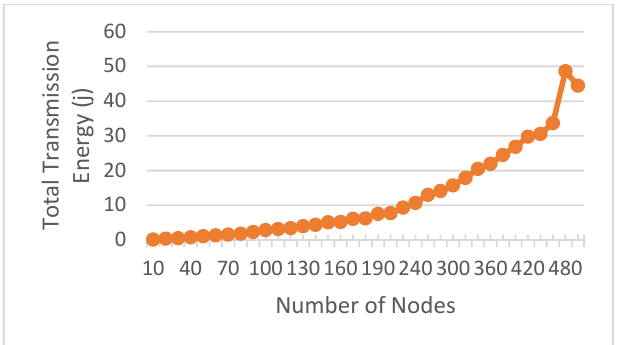
Figure 14. The total transmission energy vs. the number of nodes in the LMF model.